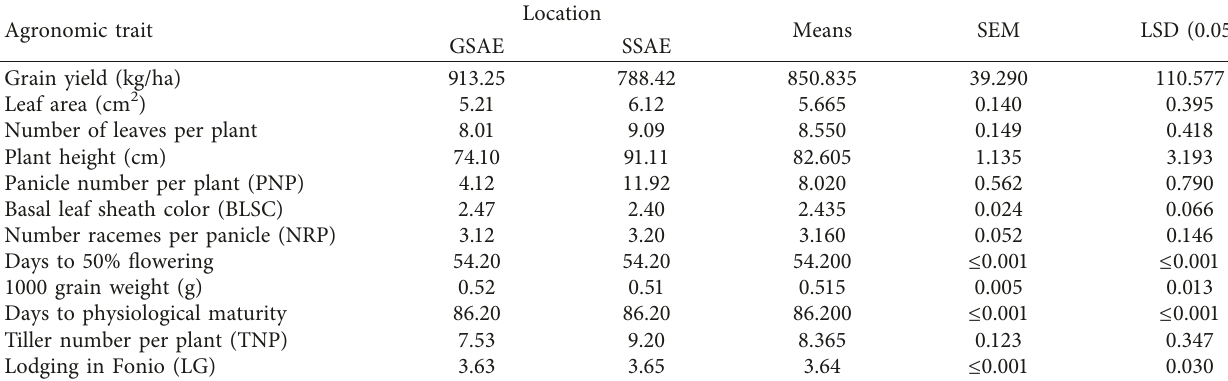
Table 5: Effect of location on growth and yield